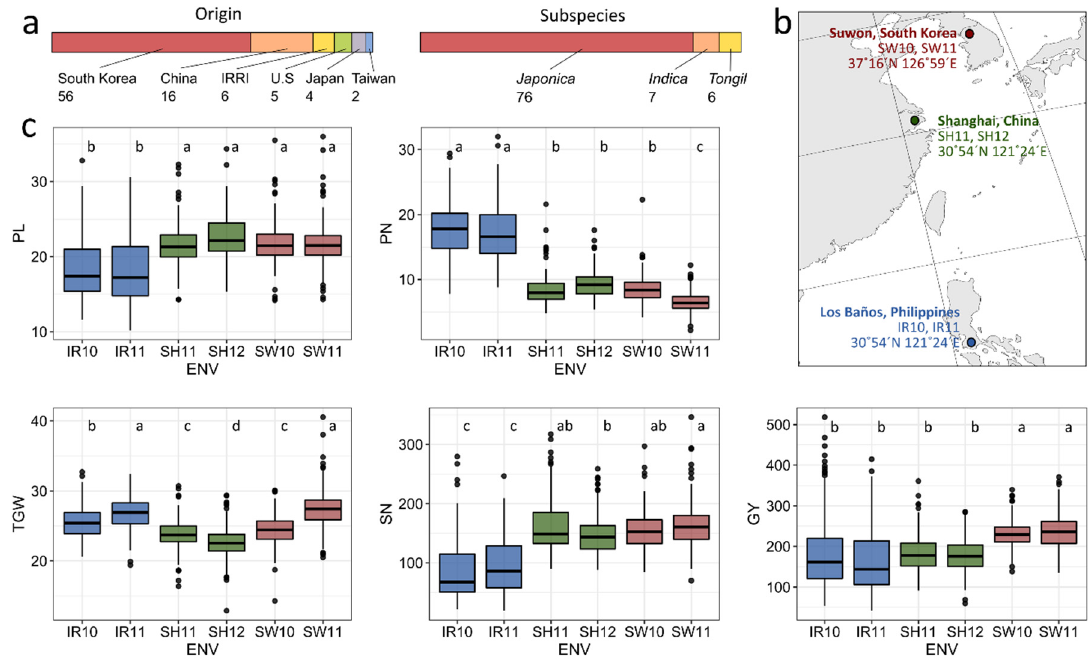
Figure 1. Variation of yield-component traits and grain yield (GY) in different environments. ( a ) Plant materials used in multiple environment trials. The length of bars indicate the percent of origin or subspecies of plant materials. ( b ) Locations of experimental cultivation fields: Suwon, temperate; Shanghai, subtropical; and Los Baños, tropical. ( c ) Comparisons of yield-component traits and grain yield (GY) performance among six environments (three locations over two years). Box plots with different lowercase letters indicate statistically significant differences (one-way analysis of variance (ANOVA) followed by Scheffe’s post hoc test; p < 0.05).